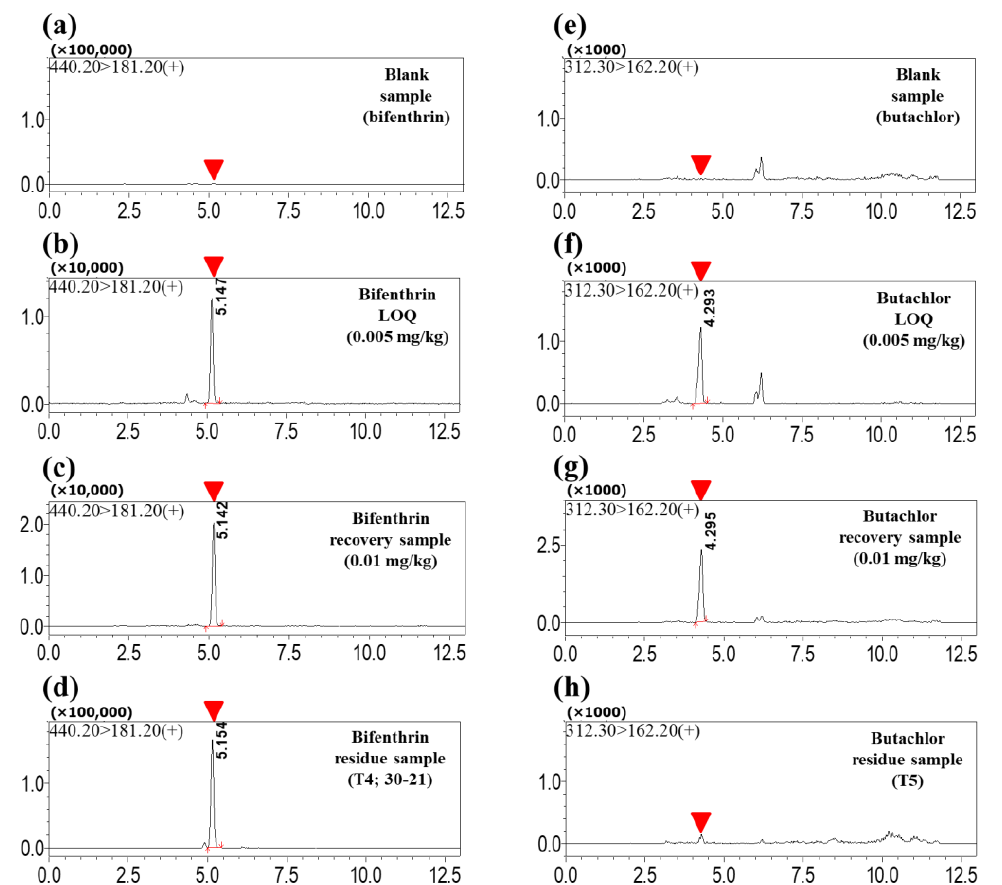
Figure 2. Chromatograms for bifenthrin and butachlor using the established MRM conditions; ( a ) blank samples without bifenthrin, ( b ) bifenthrin matrix-matched standard at LOQ (0.005 mg/kg), ( c ) bifenthrin recovery sample at 0.01 mg/kg, ( d ) bifenthrin residue sample (T4; 30-21), ( e ) blank sam- ples without butachlor, ( f ) butachlor matrix-matched standard at LOQ (0.005 mg/kg), ( g ) butachlor recovery sample at 0.01 mg/kg, ( h ) butachlor real sample (T5).